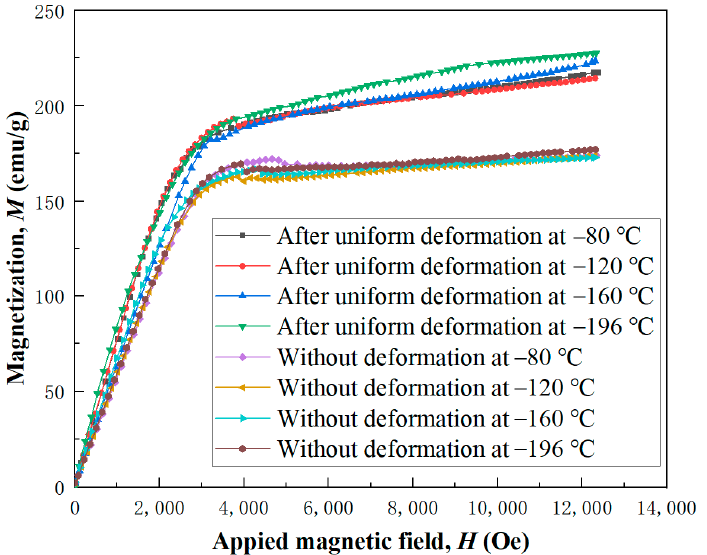
Figure 4. Magnetization ( M ) curves as a function of applied magnetic field ( H ) for samples without deformation and after uniform deformation in the range of − 80 to − 196 °C.